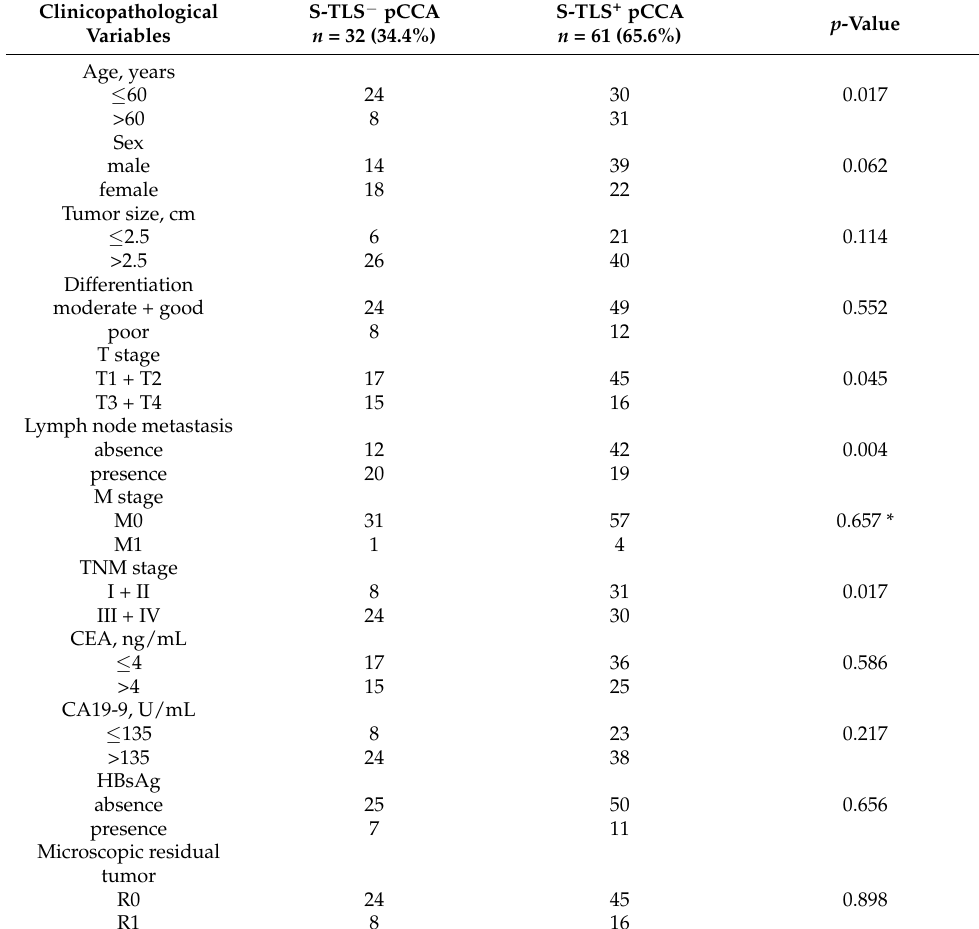
Table 2. Correlation analyses between intra-tumoral S-TLSs and the patients’ clinicopathological characteristics.